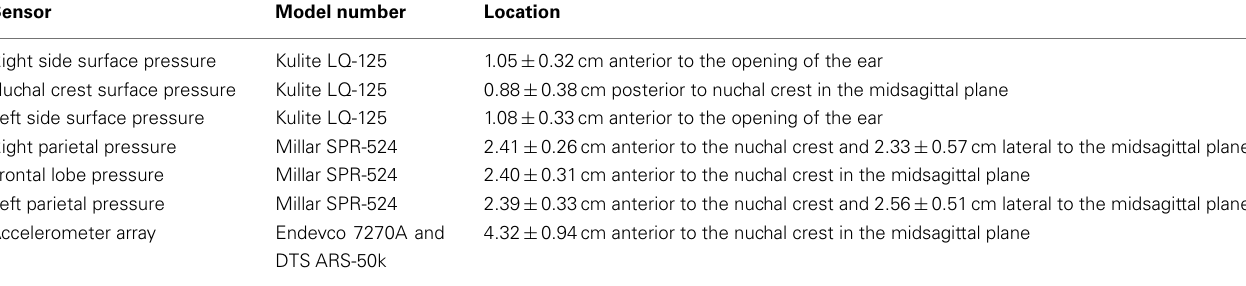
Table 2 |Transducers and their anatomical